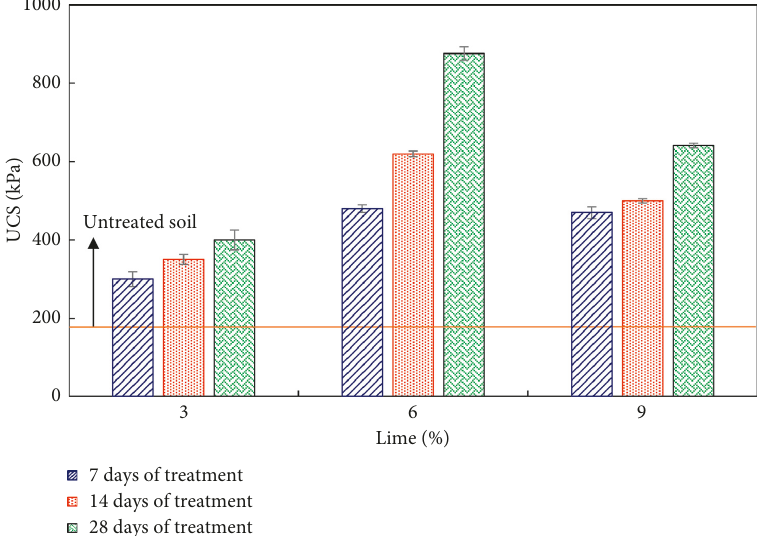
Figure 5: Effect of lime on the UCS of soil after a curing time of up to